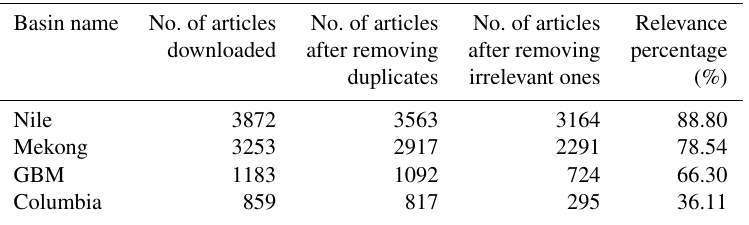
Table 6. Manual reading results of representative river basins. Note: GBM is Ganges–Brahmaputra–Meghna. Basin